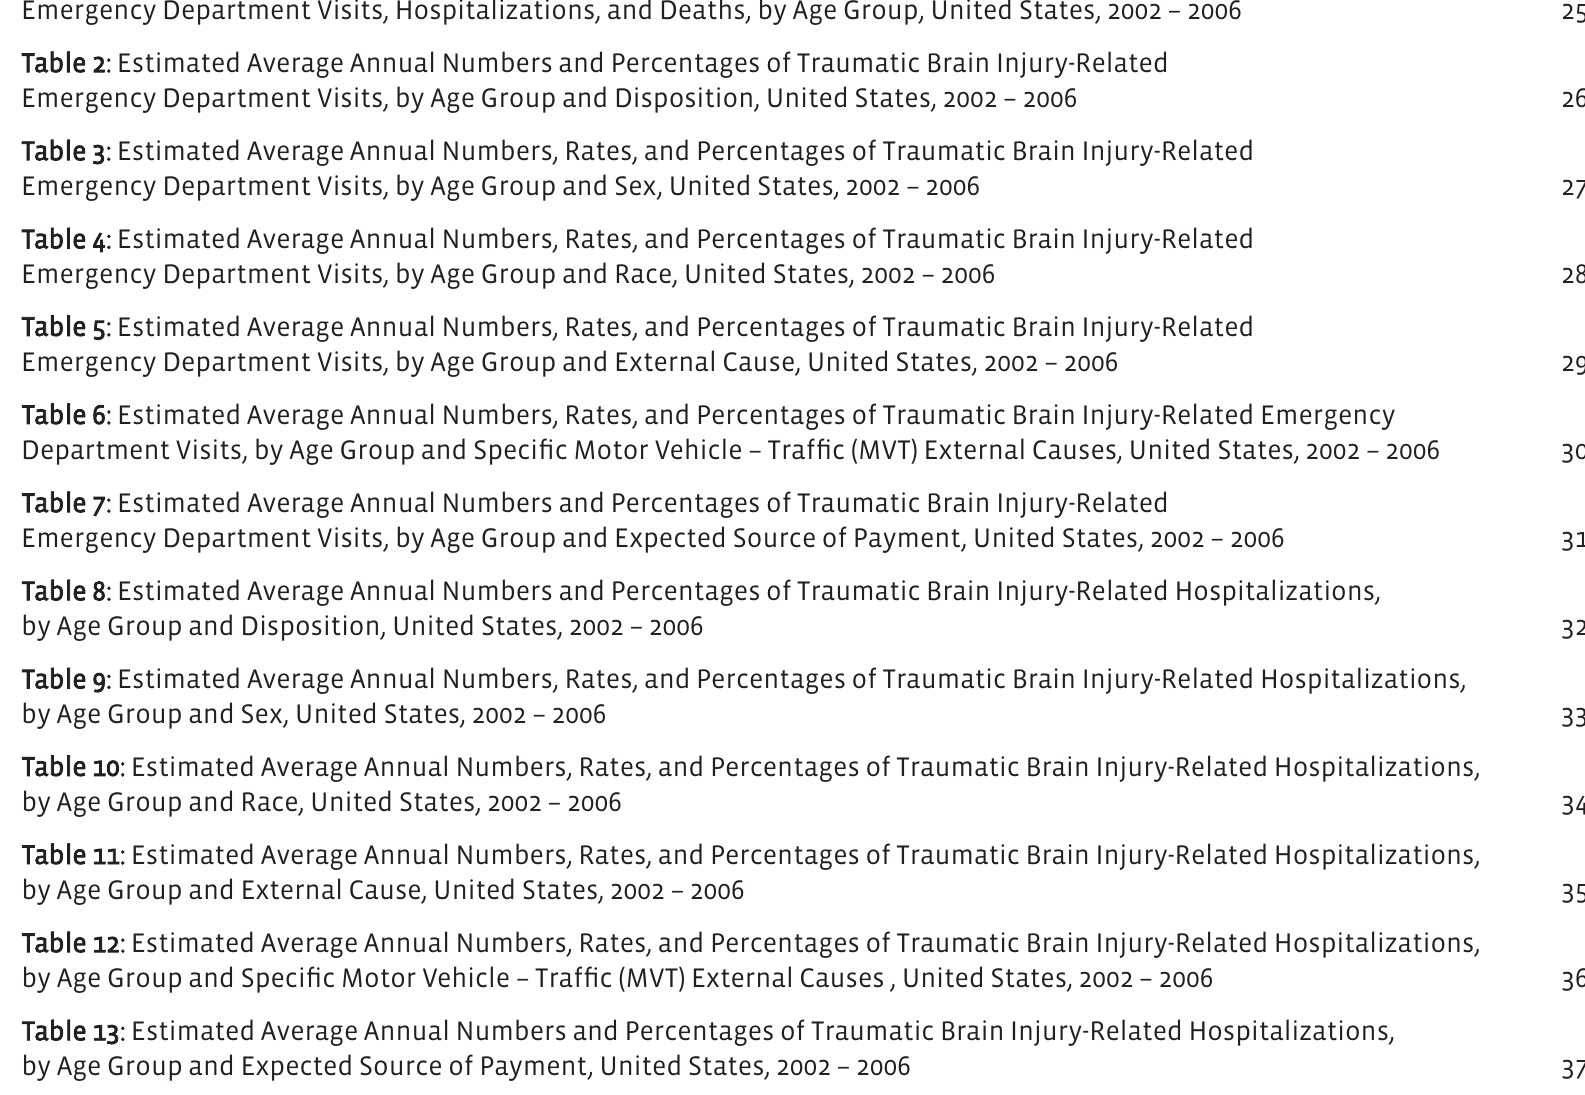
Table 1: Estimated Average Annual Numbers, Rates, and Percentages of Traumatic Brain Injury-Related Emergency Department Visits, Hospitalizations, and Deaths, by Age Group, United States, 2002 – 2006 Table 2: Estimated Average Annual Numbers and Percentages of Traumatic Brain Injury-Related Emergency Department Visits, by Age Group and Disposition, United States, 2002 – 2006 Table 3: Estimated Average Annual Numbers, Rates, and Percentages of Traumatic Brain Injury-Related Emergency Department Visits, by Age Group and Sex, United States, 2002 – 2006 Table 4: Estimated Average Annual Numbers, Rates, and Percentages of Traumatic Brain Injury-Related Emergency Department Visits, by Age Group and Race, United States, 2002 – 2006 Table 5: Estimated Average Annual Numbers, Rates, and Percentages of Traumatic Brain Injury-Related Emergency Department Visits, by Age Group and External Cause, United States, 2002 – 2006 Table 6: Estimated Average Annual Numbers, Rates, and Percentages of Traumatic Brain Injury-Related Emergency Department Visits, by Age Group and Specific Motor Vehicle – Traffic (MVT) External Causes, United States, 2002 – 2006 Table 7: Estimated Average Annual Numbers and Percentages of Traumatic Brain Injury-Related Emergency Department Visits, by Age Group and Expected Source of Payment, United States, 2002 – 2006 Table 8: Estimated Average Annual Numbers and Percentages of Traumatic Brain Injury-Related Hospitalizations, by Age Group and Disposition, United States, 2002 – 2006 Table 9: Estimated Average Annual Numbers, Rates, and Percentages of Traumatic Brain Injury-Related Hospitalizations, by Age Group and Sex, United States, 2002 – 2006 Table 10: Estimated Average Annual Numbers, Rates, and Percentages of Traumatic Brain Injury-Related Hospitalizations, by Age Group and Race, United States, 2002 – 2006 Table 11: Estimated Average Annual Numbers, Rates, and Percentages of Traumatic Brain Injury-Related Hospitalizations, by Age Group and External Cause, United States, 2002 – 2006 Table 12: Estimated Average Annual Numbers, Rates, and Percentages of Traumatic Brain Injury-Related Hospitalizations, by Age Group and Specific Motor Vehicle – Traffic (MVT) External Causes , United States, 2002 – 2006 Table 13: Estimated Average Annual Numbers and Percentages of Traumatic Brain Injury-Related Hospitalizations, by Age Group and Expected Source of Payment, United States, 2002 –